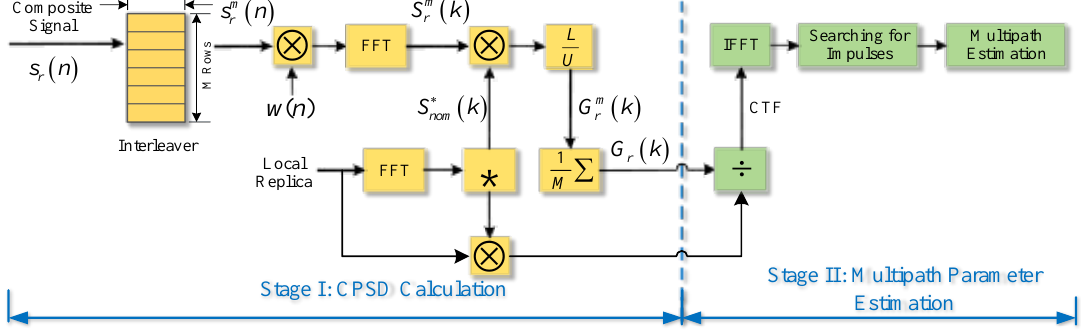
Figure 1. The scheme of the proposed multipath estimation method.